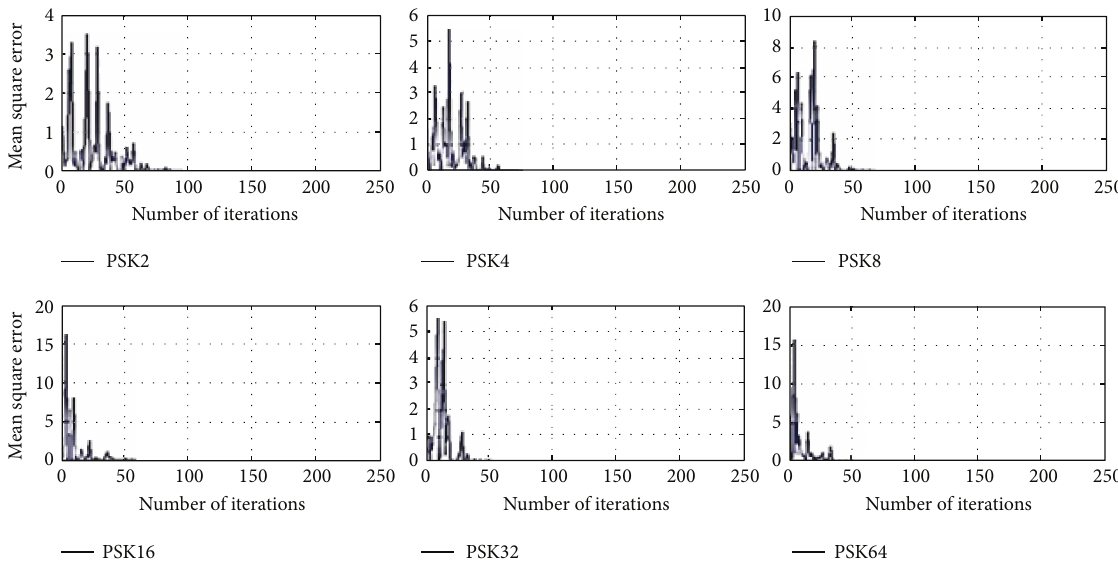
Figure 4: Training of Gabor filter parameters and weights for modulation classification in case of PSK modulation 2–64 for different number of iterations at SNR = 10dB.